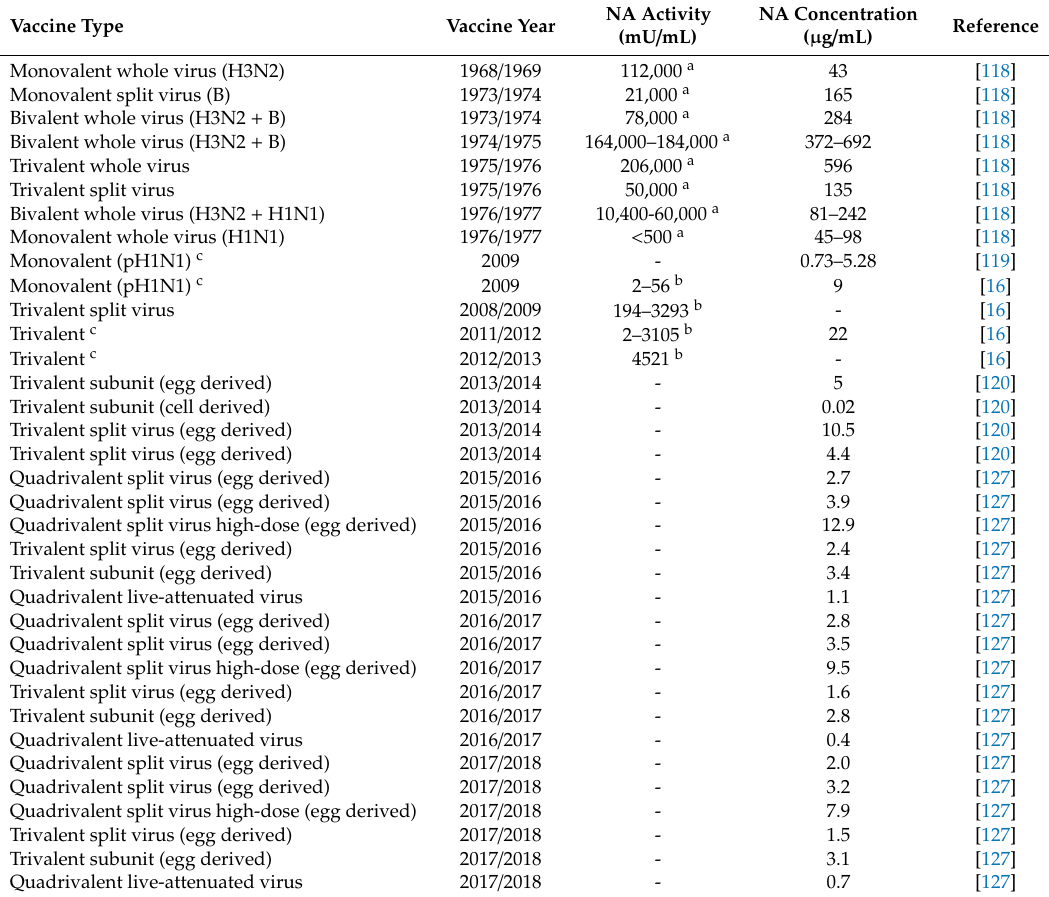
Table 2. NA activity and concentration of influenza vaccine